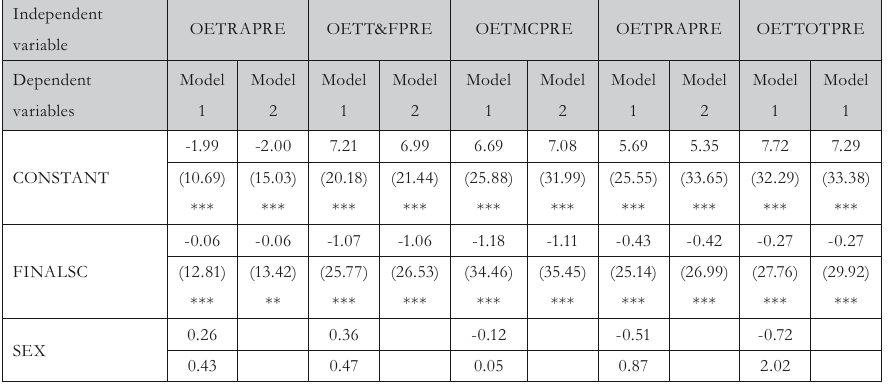
Tab. 4 – Results of the binary logistic regression models for the pre-examination of self-assess- ment, Source: based on our